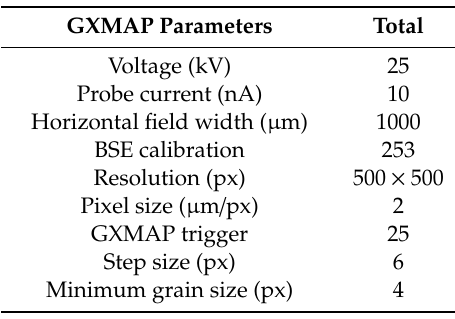
Table 2. Scan parameters from mineral liberation analyzer (MLA) analysis. BSE—backscattered electron. Table2. Scan parameters from mineral liberation analyzer(MLA) analysis. BSE—backscatteredelectron.